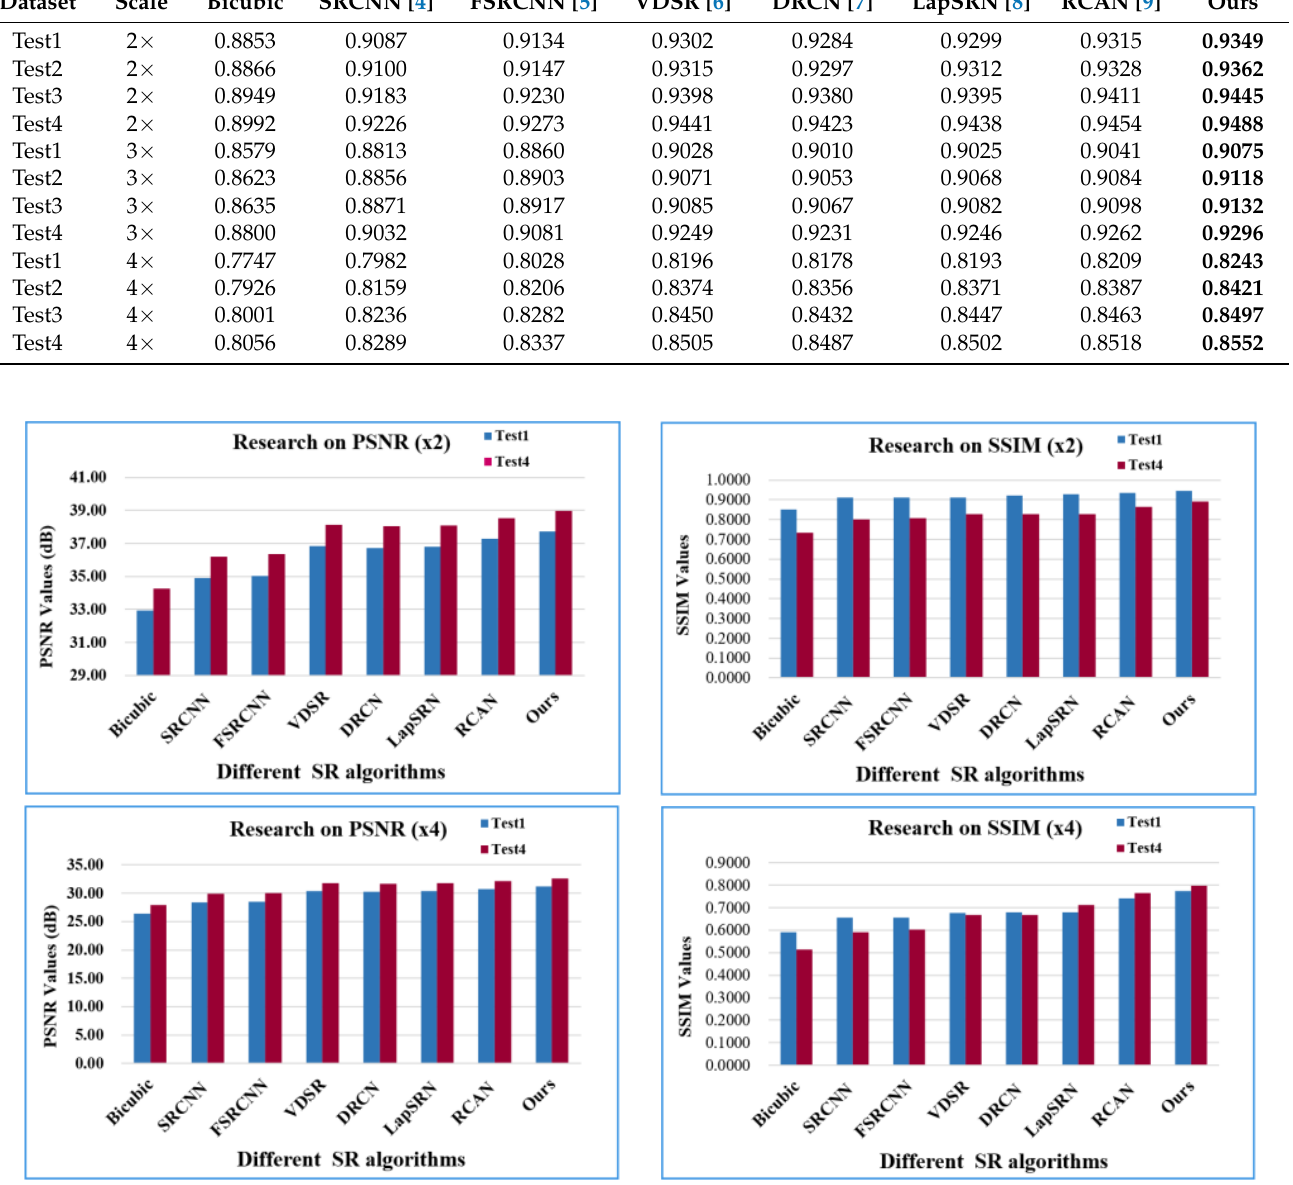
Figure 9. Compared results of the PSNR and SSIM on Test1 and Test4 datasets.